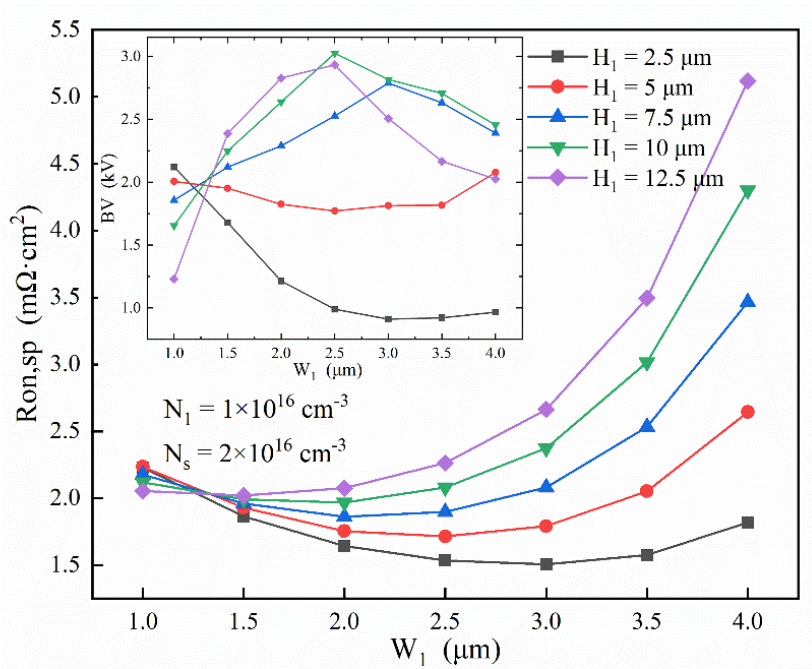
Figure 10. Investigation of H 1 and W 1 affecting optimized BV and R on,sp in SDS-Trench CAVET for varied values of N 1 for given N s = 2 × 10 16 cm − 3 and N 1 = 1 × 10 16 cm − 3 .